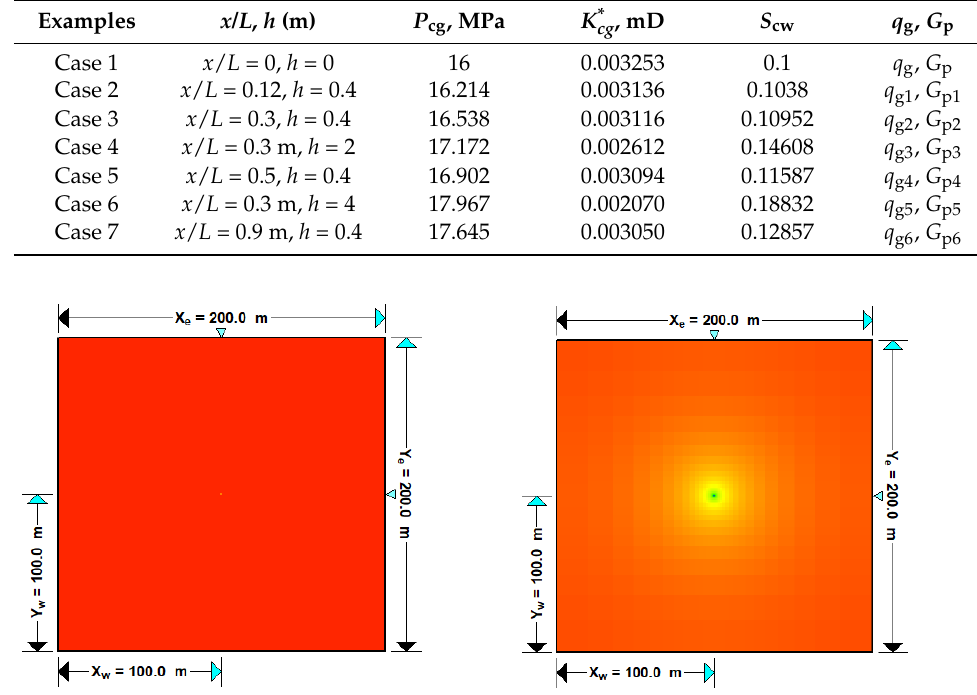
Table 3. Maximum pore pressure immediately after drainage, matrix permeability, and water saturation within different imbibition degrees ( q g is daily gas production, G p is cumulative gas production).